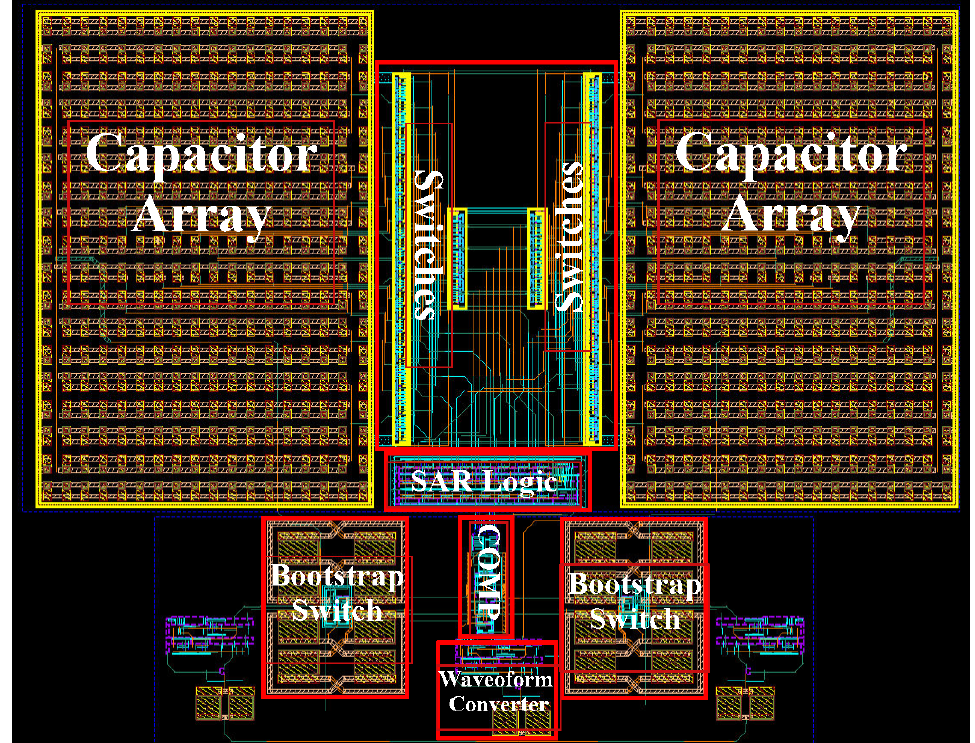
Figure 15. The layout of the proposed cryogenic SAR